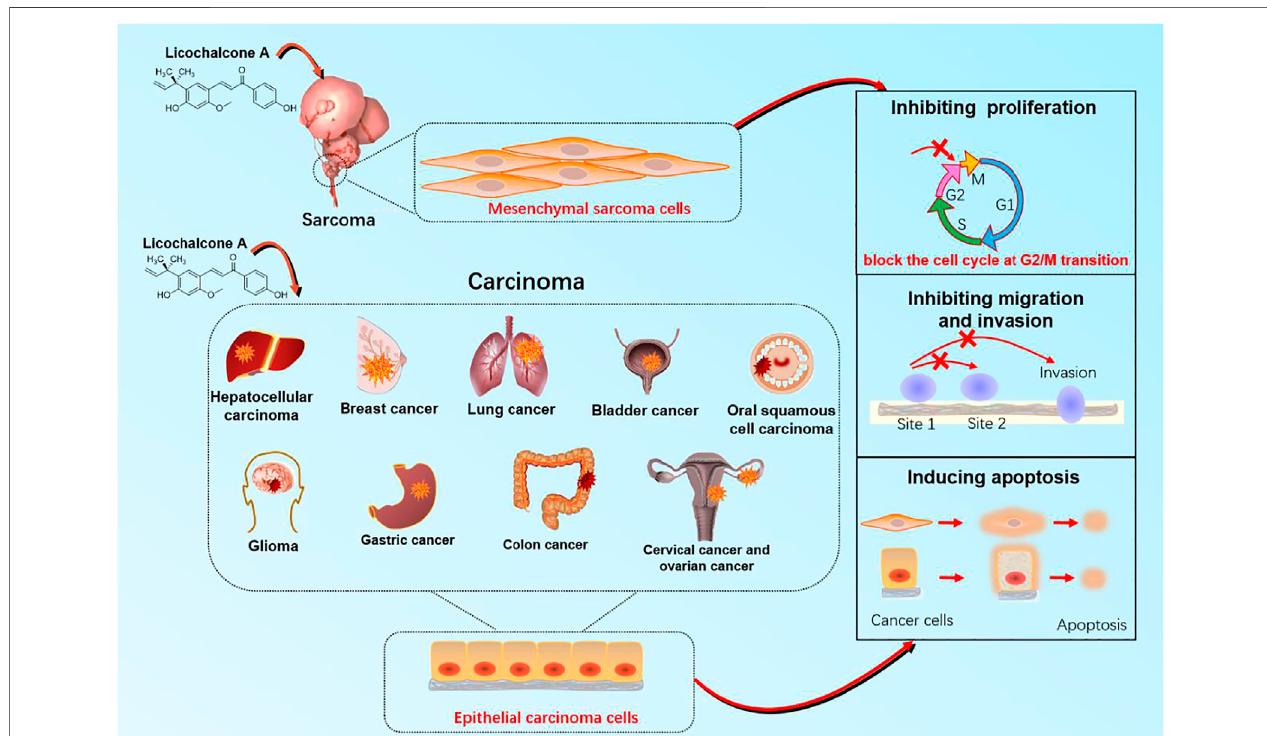
FIGURE 2 | The target organ and cellular mechanisms for anticancer effect of licochalcone A with anticancer activity.